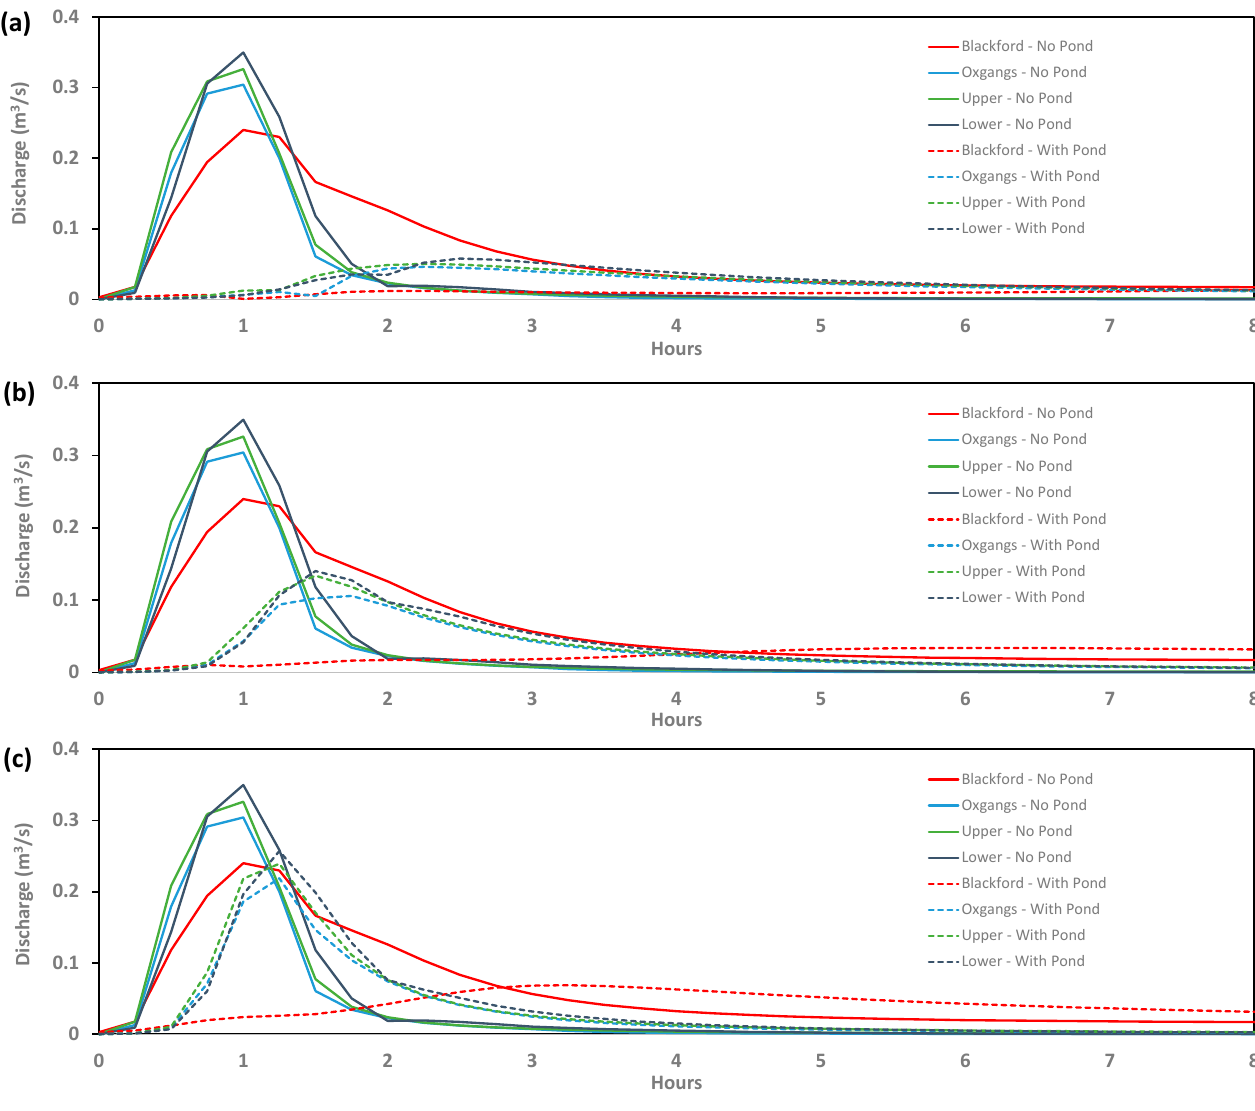
Figure 4. Flow from the four ponds into the adjacent water courses for a 1 in 100 year 1 h event starting at hour 0. This is for the baseline run with no pond and incorporating each pond into the model. ( a ) increased storage, ( b ) standard storage, ( c ) decreased storage.